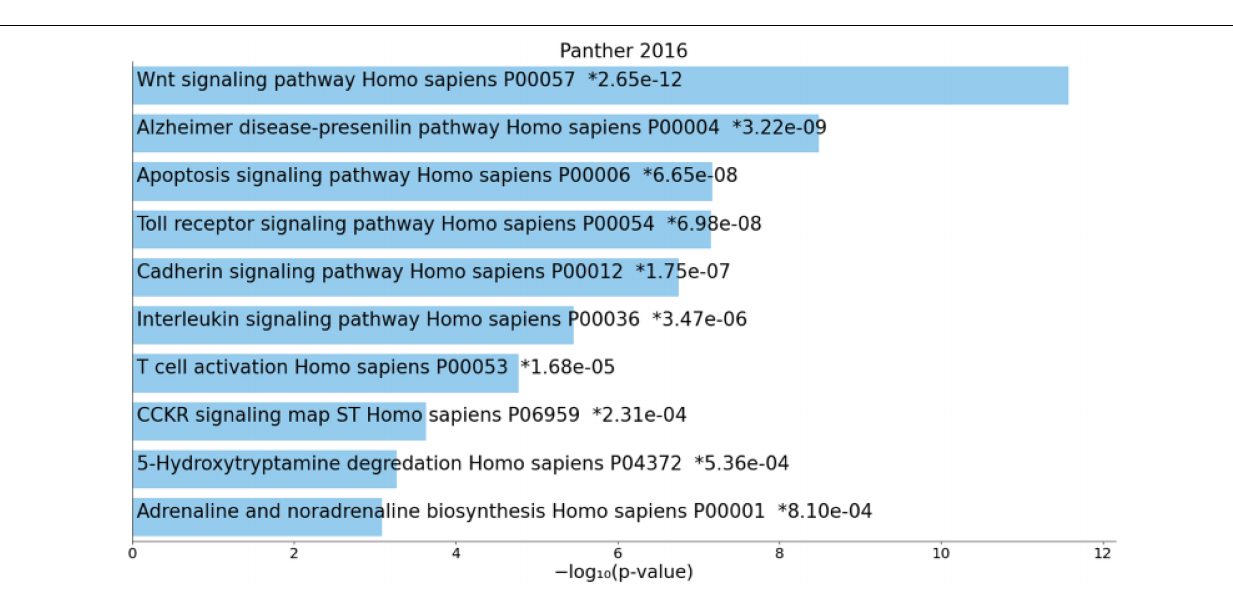
FIGURE 6 | Heatmap (top 10) of enriched PANTHER terms accumulated in the differently expressed proteins of the enlarged MultiOmics network of chronic fatigue spectrum disorders. *significant after FDR p